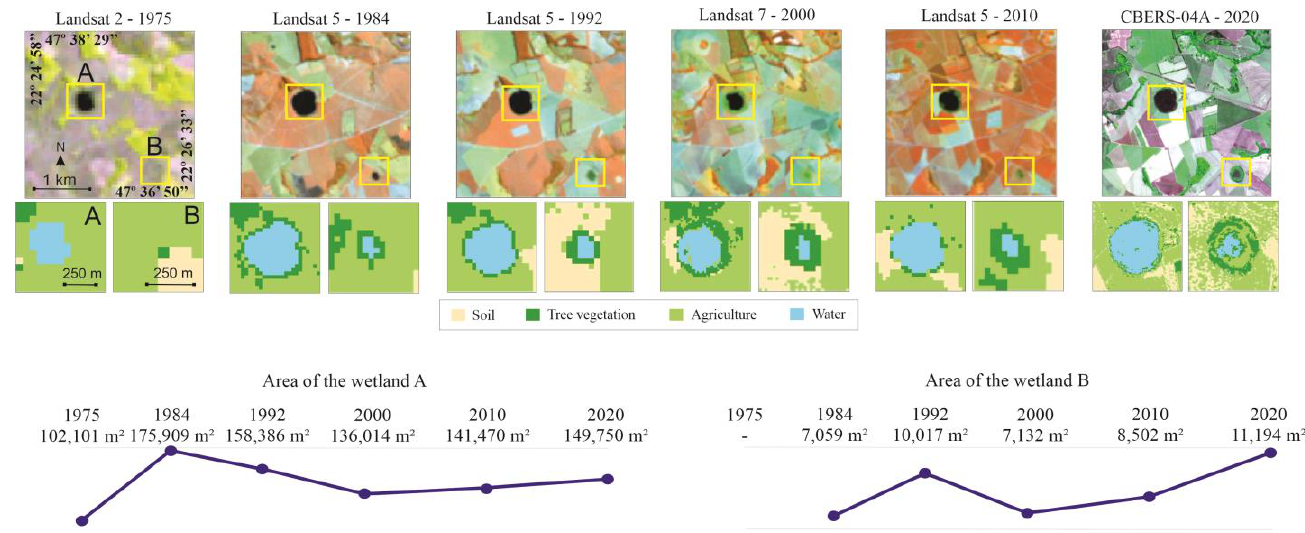
Figure 3. 1975–2020 band composition images of the Landsat series and CBERS-04A satellite. Pixel- based supervised classification in wetland A and B (zoom-in). The graphs display the result of cal- culations of the inundated area (water class) for each year-dataset, based on the supervised classifi-